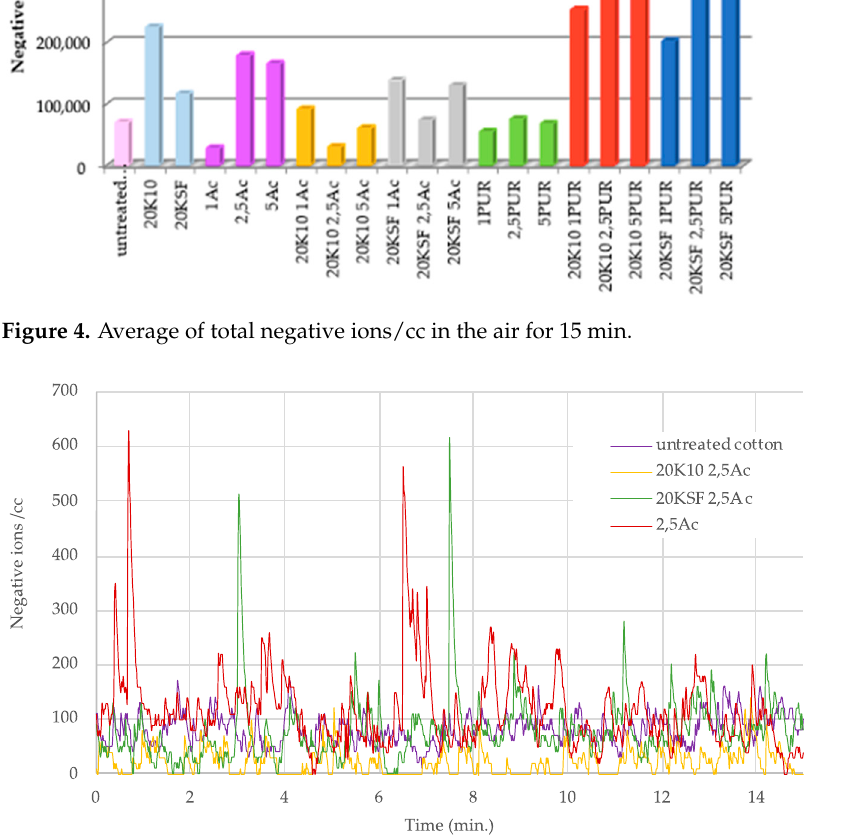
Figure 5. Negative ions/cc in 15 min released by treated samples with 2.5 g/L of acrylic binder.